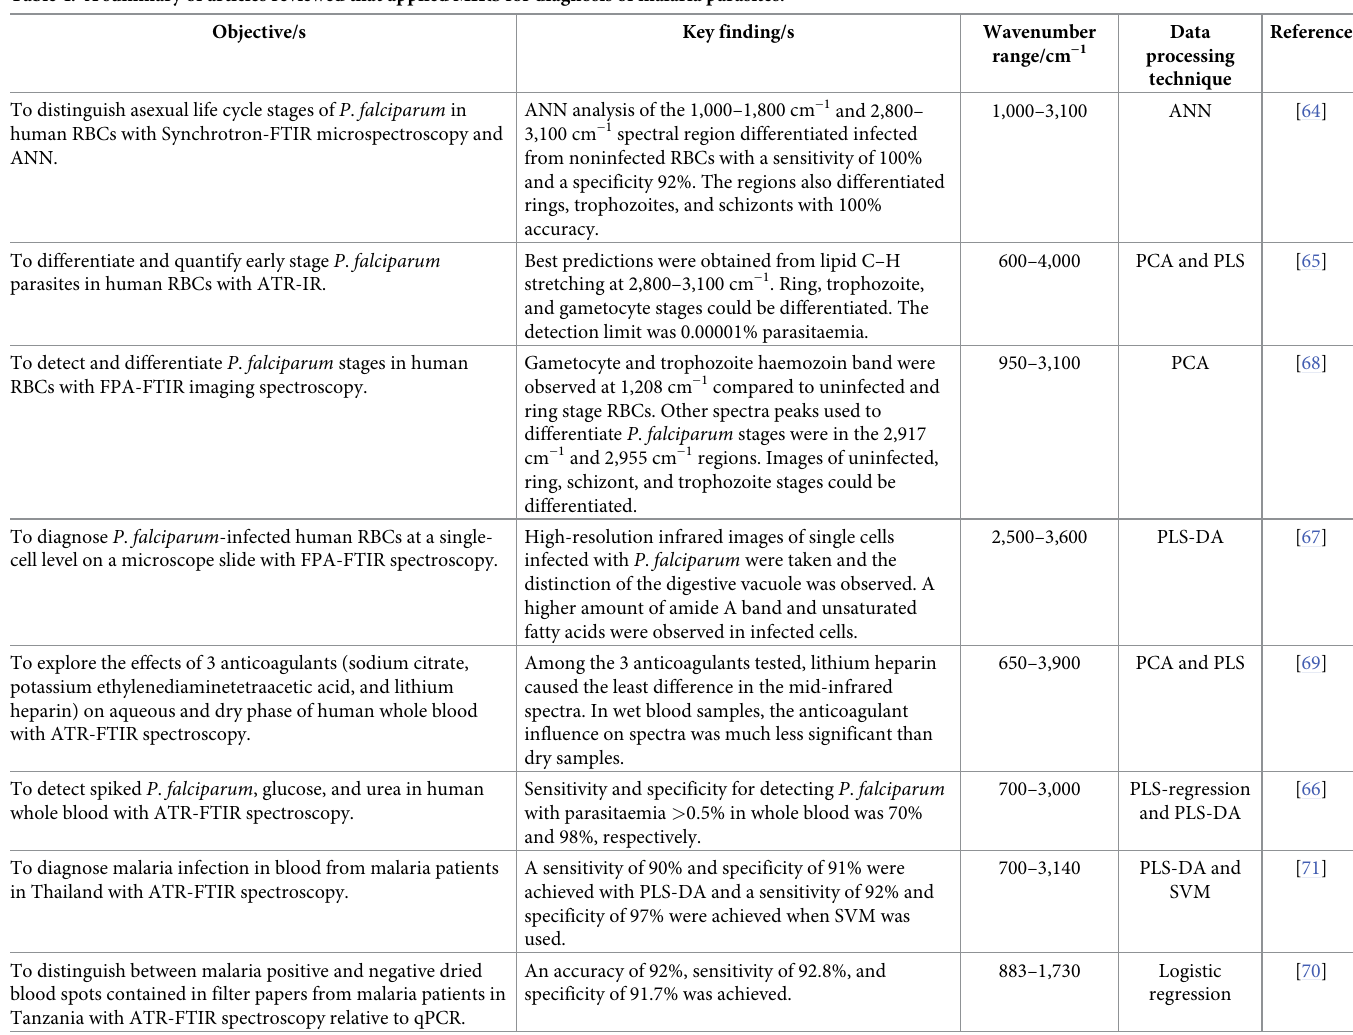
Table 4. A summary of articles reviewed that applied MIRS for diagnosis of malaria